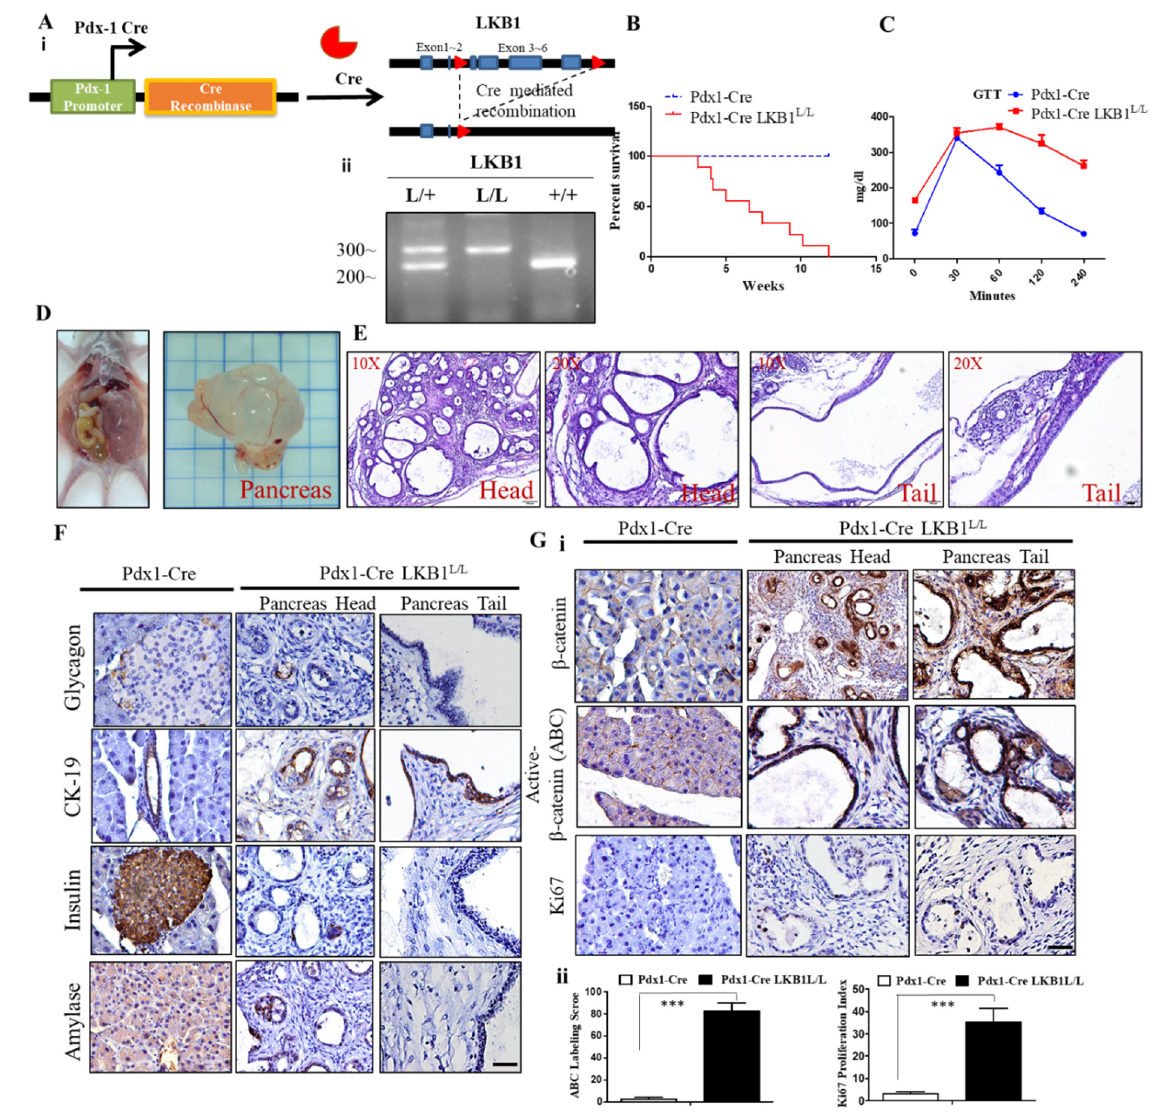
Figure 1. Liver kinase B1 (LKB1) loss induces cystadenoma in the mouse pancreas. ( A ). ( i ) Endogenous allele of LKB1 was conditionally deleted in the pancreas of Pdx1-CreLKB1 L/L mice. Structure of the LKB1 floxed allele: Loxp sites were inserted into the introns surrounding exon 3–6. ( ii ) , Specific genotyping PCR analysis of the genomic DNA from the tail of the Pdx1-CreLKB1 L/L , Pdx-1CreLKB1 L/+ , and wild-type mice. ( B ). Kaplan–Meier curve showing the significantly reduced survival time of Pdx1-Cre LKB1 L/L mice compared to Pdx1-Cre wild-type mice. ( C ). Glucose tolerance test (GTT) revealed that the fall in blood glucose levels was delayed in Pdx-1Cre LKB1 L/L mice compared to that of Pdx-1Cre wild-type mice. ( D ). Autopsy and gross pathology of murine mucin cystadenoma (MCN) lesions in Pdx1-CreLKB1 L/L mice at 8 weeks of age. ( E ). Hematoxylin and eosin (H&E) stained sections showing the histology of MCN in the head and tail of the pancreas derived from Pdx1-CreLKB1 L/L mice, and histological analysis of the head and tail of the pancreas from Pdx1-CreLKB1 L/L mice at magnification x20 and x40, respectively. Scale bar is 100 µm. ( F ). Immunohistochemistry (IHC) analysis detected the positive staining for CK19, whereas there was a loss of insulin, glucagon, and amylase staining in MCN lesions compared to normal pancreata. Scale bar is 100 µm. ( G ). ( i ) IHC staining revealed increased Ki67 and total and nuclear β -catenin protein levels in Pdx1-CreLKB1 L/L mice compared to Pdx-1Cre wild-type controls. Scale bar is 100 µm. ( ii ), The active β -catenin (ABC) labeling score and Ki67 positive cells were quantified per field. Values given are the means ±SE from six random sections for each sample. *** p < 0.001.